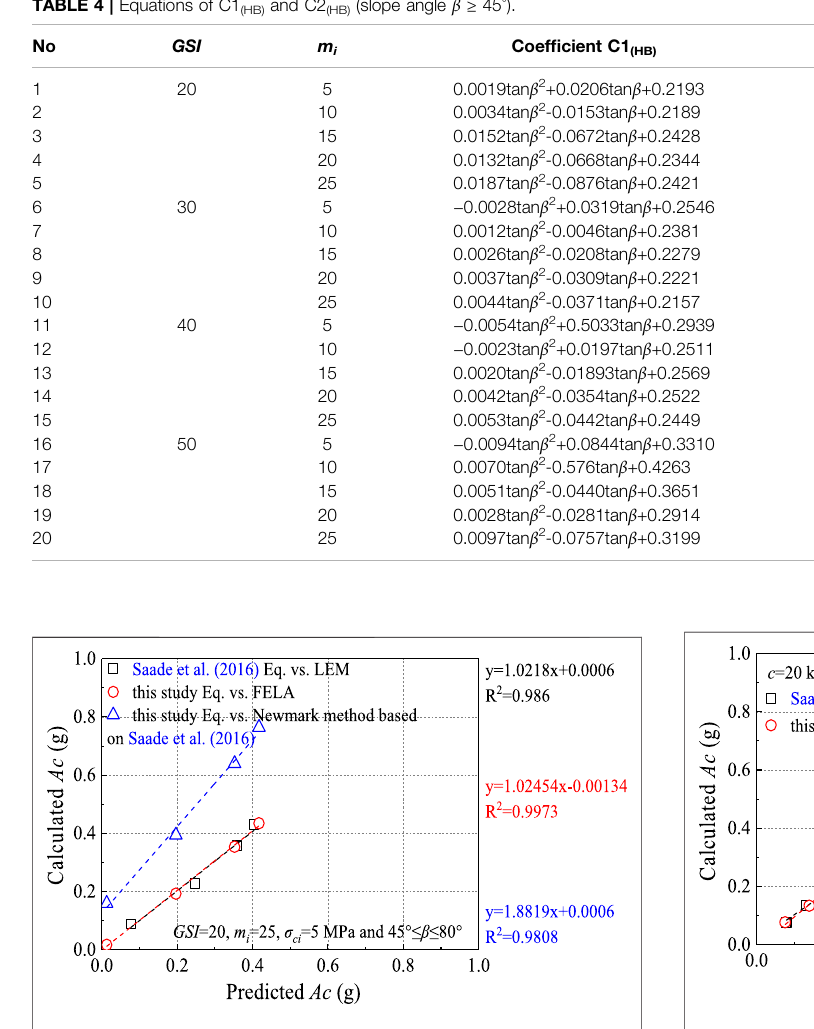
FIGURE 7 | Comparison between the A c values predicted and calculated with FELA for c = 20 kPa, φ = 25 ° and 45 ° and 15 ° ≤ β < 45 ° when using the MC failure